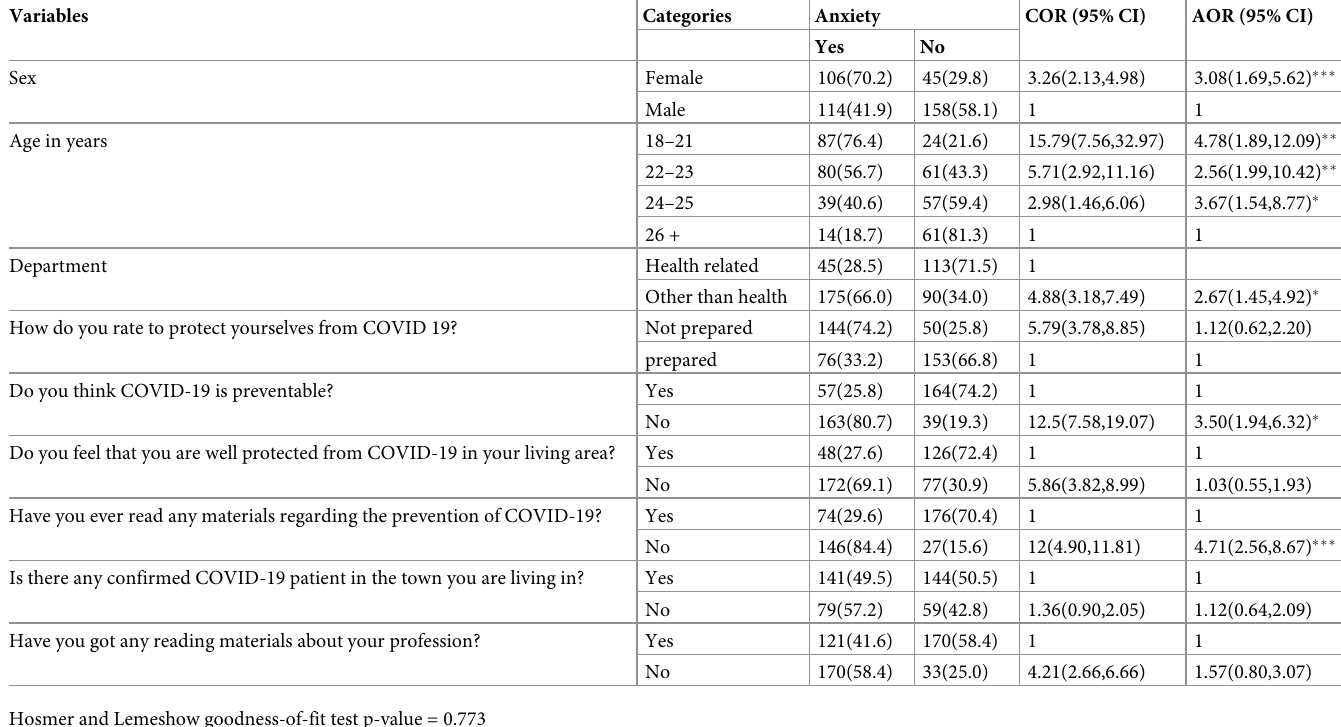
Table 4. Factors associated with anxiety among Ethiopian University students during early phase of COVID-19 pandemic, 2020 (N = 423).